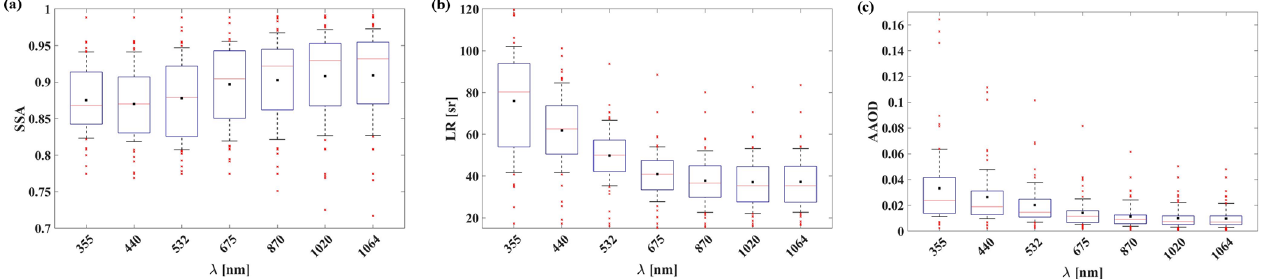
Figure 7. Statistics of (a) single-scattering albedo (SSA), (b) lidar ratio (LR), and (c) absorption aerosol optical depth (AAOD), at 355, 440, 532, 675, 870, 1020, and 1064nm retrieved by the GRASP code during the SLOPE I and II campaigns represented as box diagrams. In these box diagrams, the mean is represented by a black dot and the line segment in the box is the median. The bottom and top edges of the box indicate the 25th and 75th percentiles, respectively. In addition, the error bars of the box are the 10th and 90th percentiles and the crosses represent the